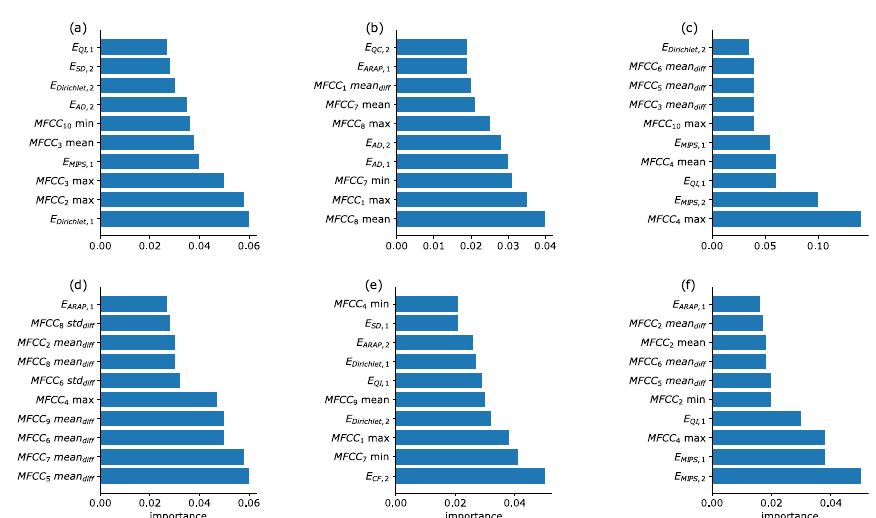
Fig. 9 Ranking efficacy of the 10 best features of the combined model, determined by means of the performance of the random forest classifier. a The ranking is presented for the binary task of identifying